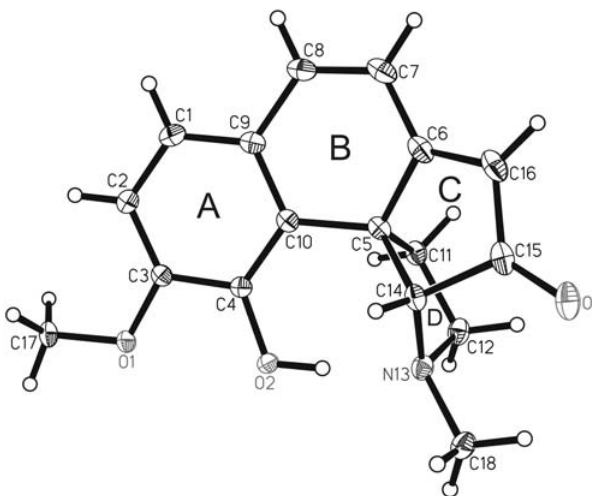
Table 1. Data collection and handling.